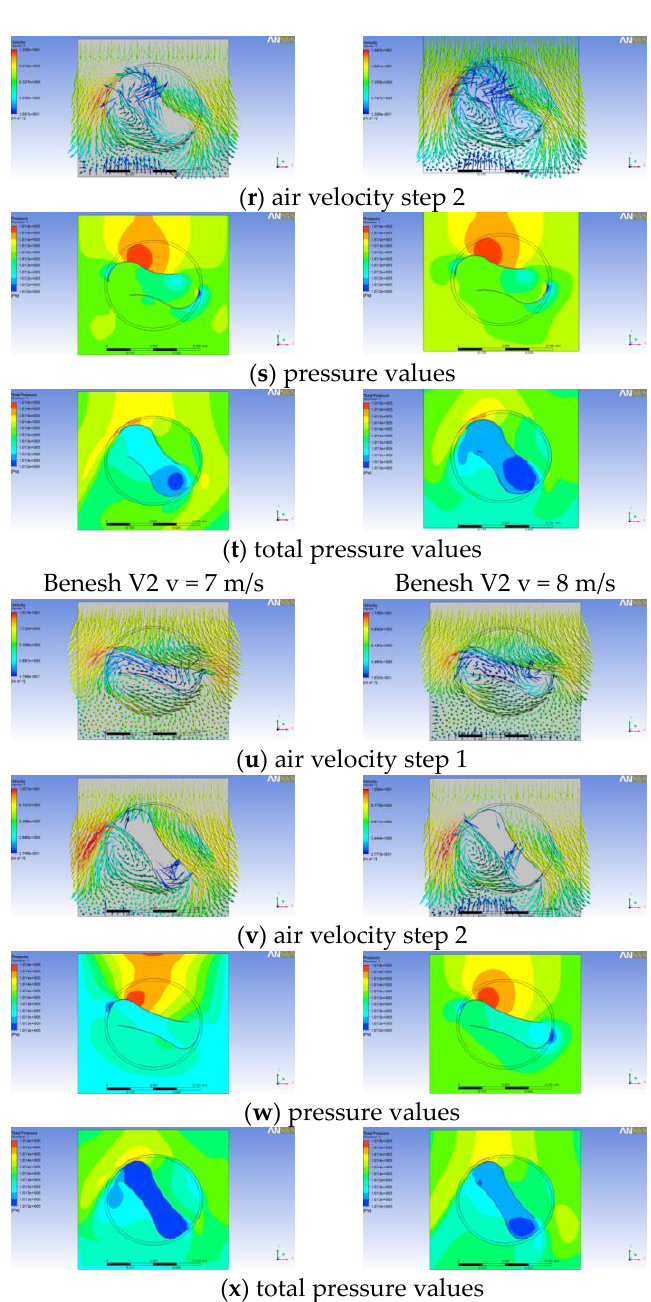
Figure 8. Air velocity and pressure value results for all analyzed cases.